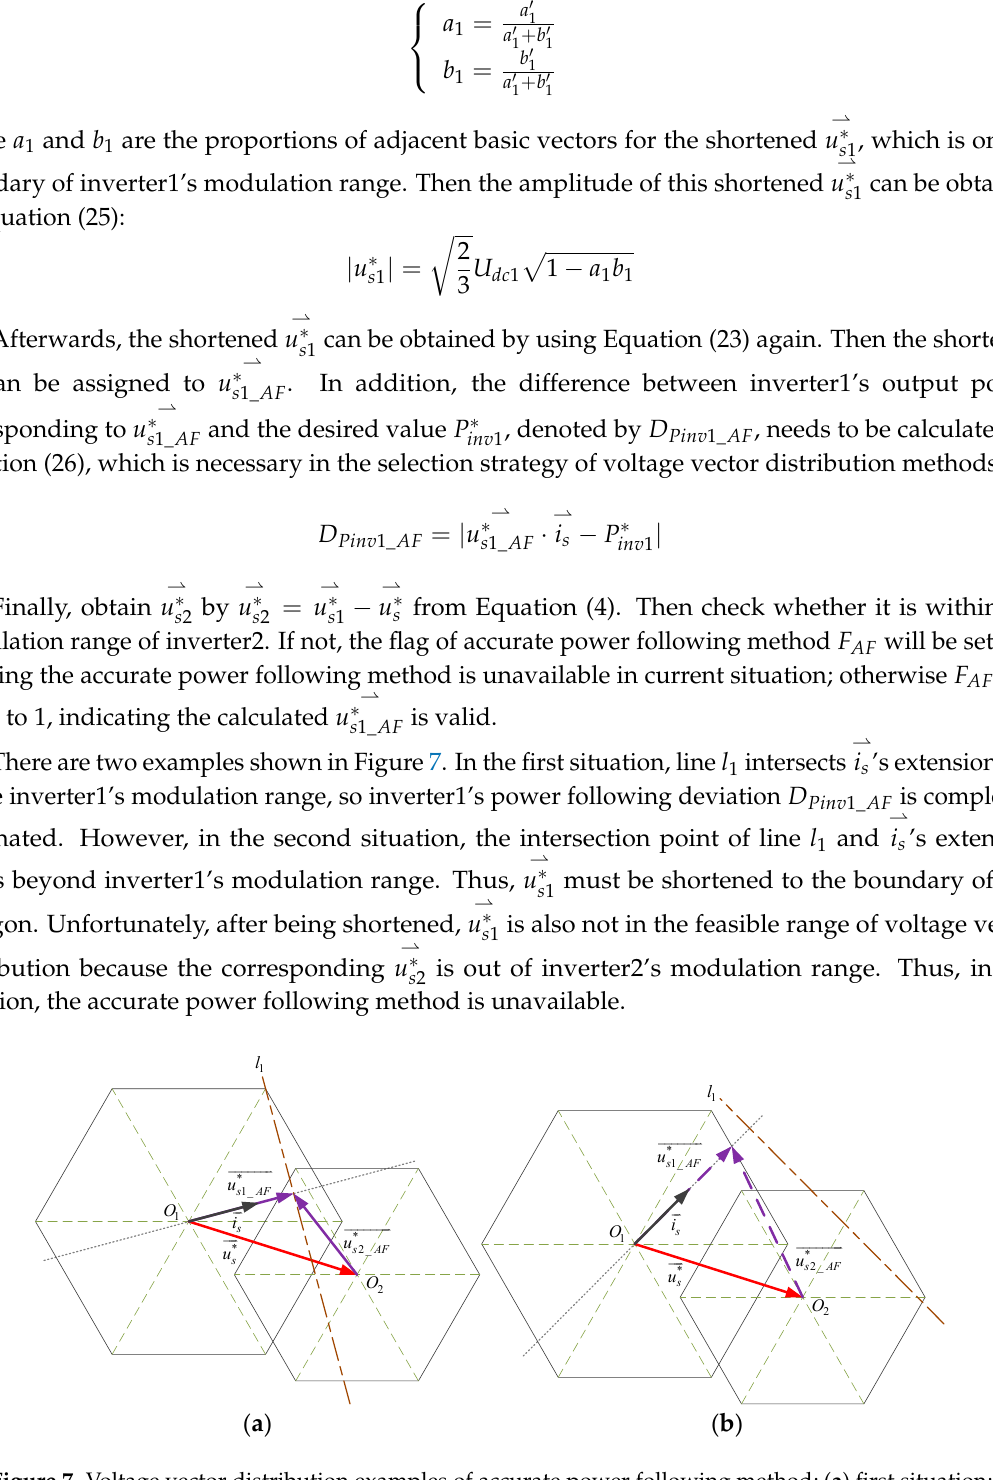
Figure 7. Voltage vector distribution examples of accurate power following method; ( a ) first situation; ( b ) second situation.